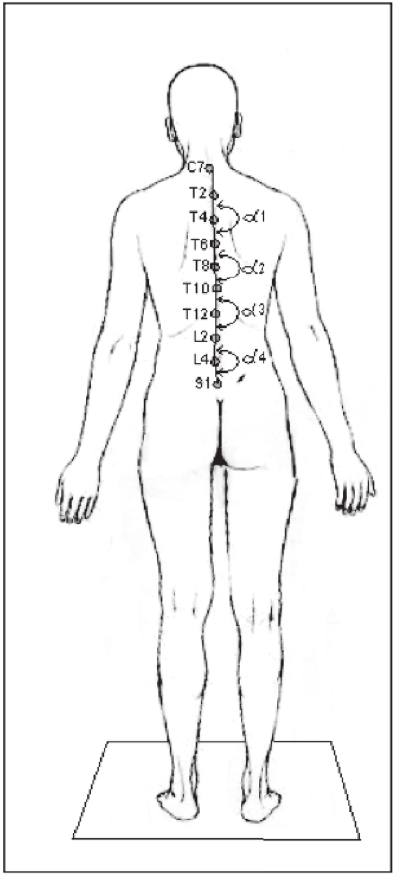
Figure 1 - Representation of the spine postural angles in the frontal plane, with the a1 angle in the thoracic region, a2 angle in the middle thoracic region, a3 angle in the thoraco- lumbar region and a4 angle in the lumbar